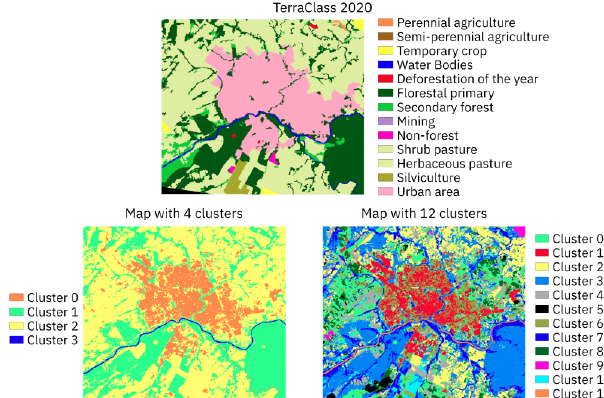
Figure 4. Results obtained with the settings with 4 and 12 groups.